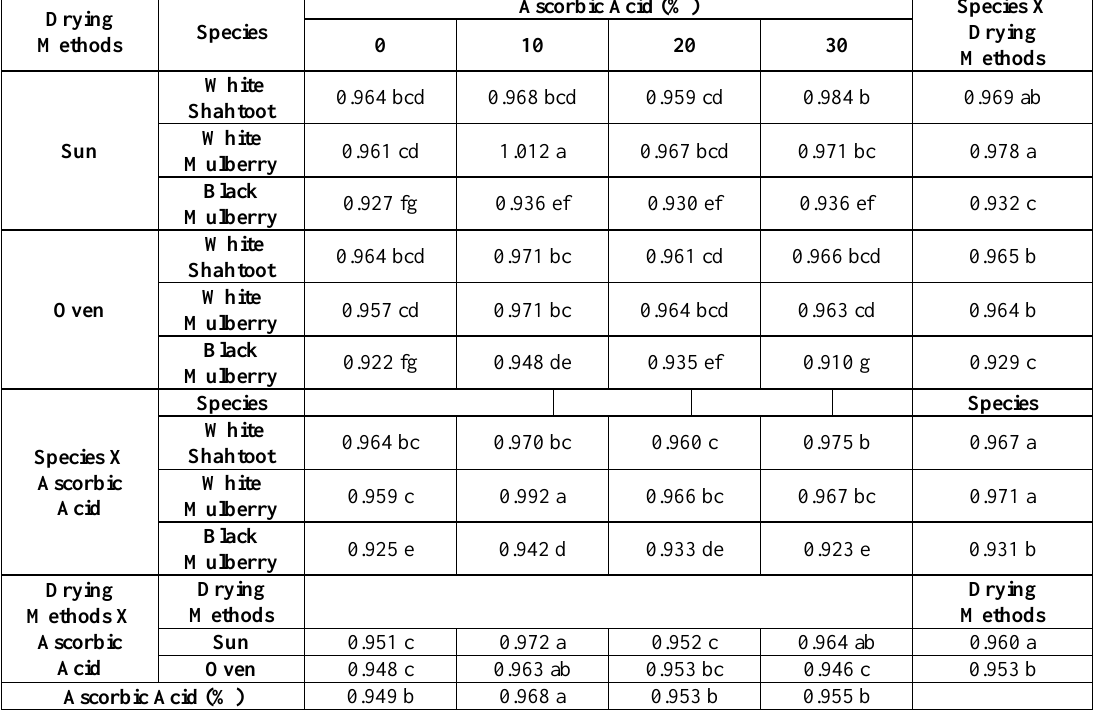
Table 3. Effect of ascorbic acid concentrations and drying methods and their interactions on ash content (%) of three mulberry